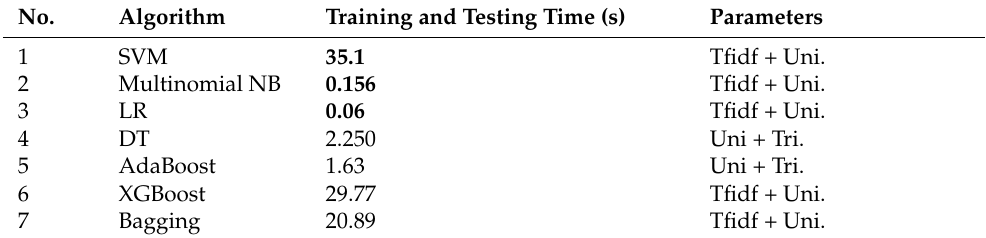
Table 8. Time complexity of algorithms. Most significant results are in bold.